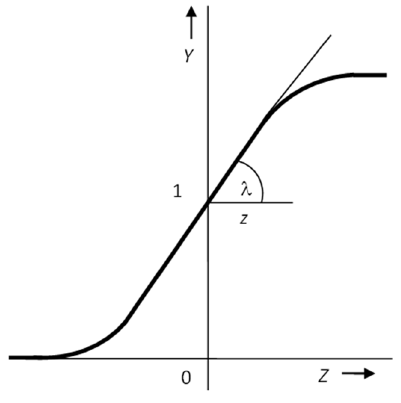
Figure 5. Standard (logistic) sigmoid.